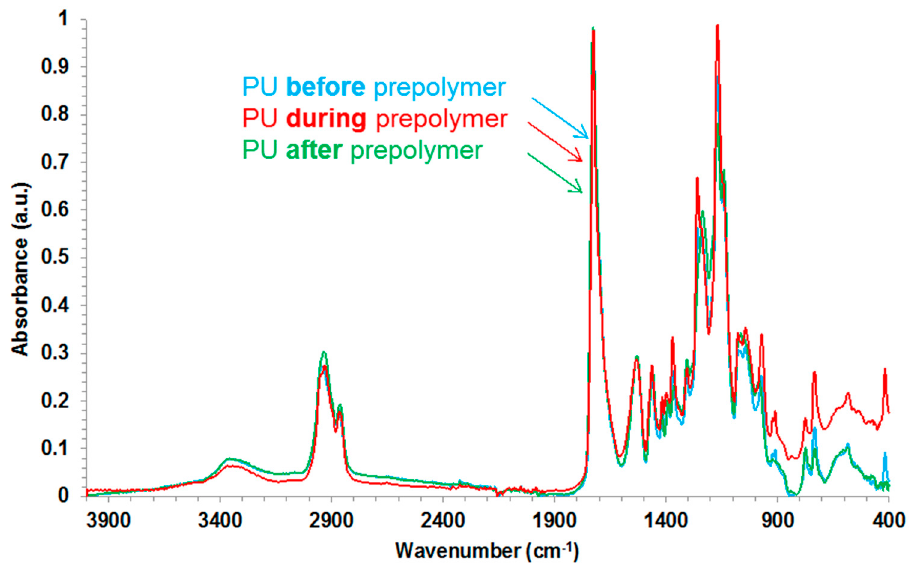
Figure 8. ATR-IR spectra of the PU films.